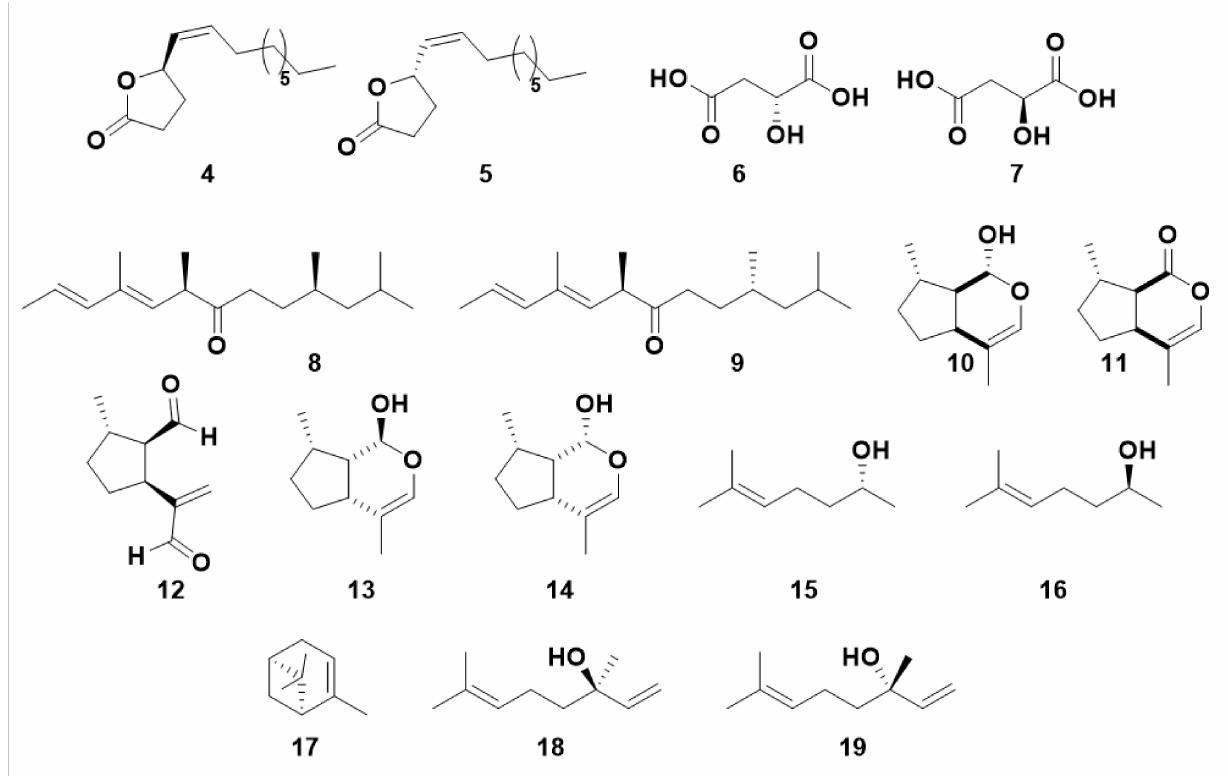
Figure 2. The chemical structures of a selection of chiral insect pheromones and semiochemicals in- volved in insect olfaction.( R )-Japonilure 4, ( S )-japonilure 5, ( R )-malic acid 6 , ( S )-malic acid 7 , (6 R ,10 R )- matsuone 8, (6 R ,10 S )-matsuone 9 , (1 R ,4a S ,7 S ,7a R )-nepetalactol 10 , (4a S ,7 S ,7a R )-nepetalactone 11 , (1 R ,2 S , 5S )-dolichodial 12 , (1 S ,4a R ,7 S ,7a S )-nepetalactol 13 and (1 R ,4a R ,7 S ,7a S )-nepetalactol 14 , ( R )- sulcatol 15 , ( S )-sulcatol 16 , α -pinene 17 , ( R )-linalool 18 and ( S )-linalool 19